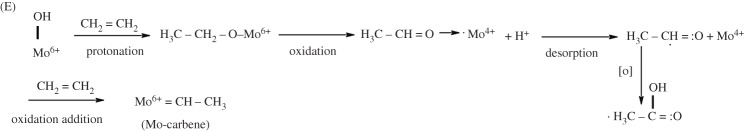
(E) Shows the proposed route for the formation of the small molecules containing oxygen starting from a Mo(VI) site upon interaction with two ethylene molecules.